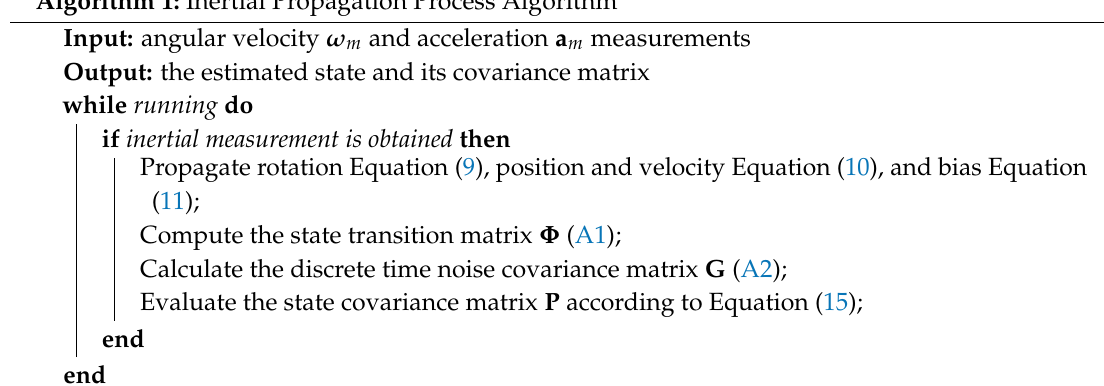
Algorithm 1: Inertial Propagation Process